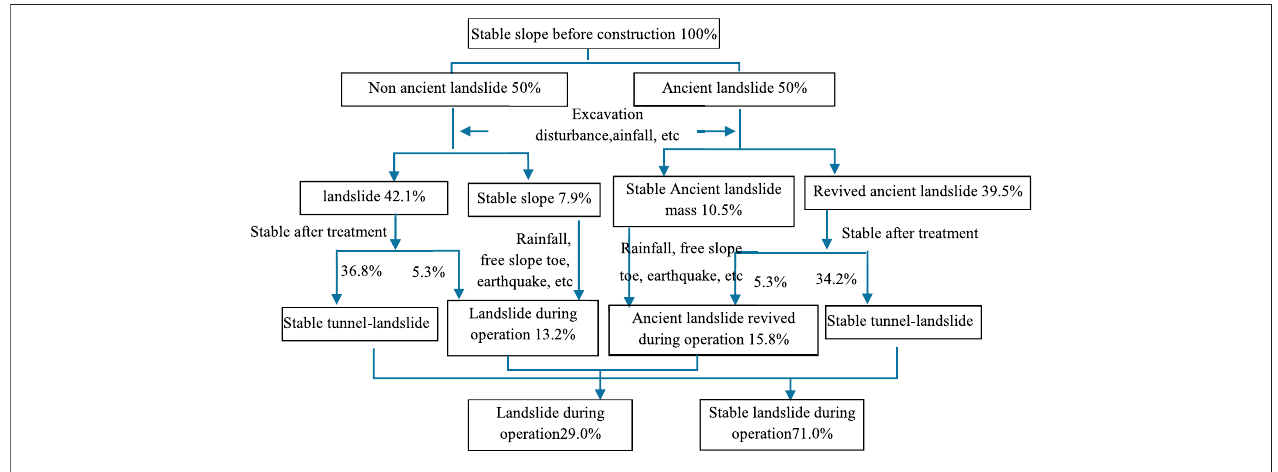
FIGURE 1 | Statistics of tunnel-related landslides cases during the operation